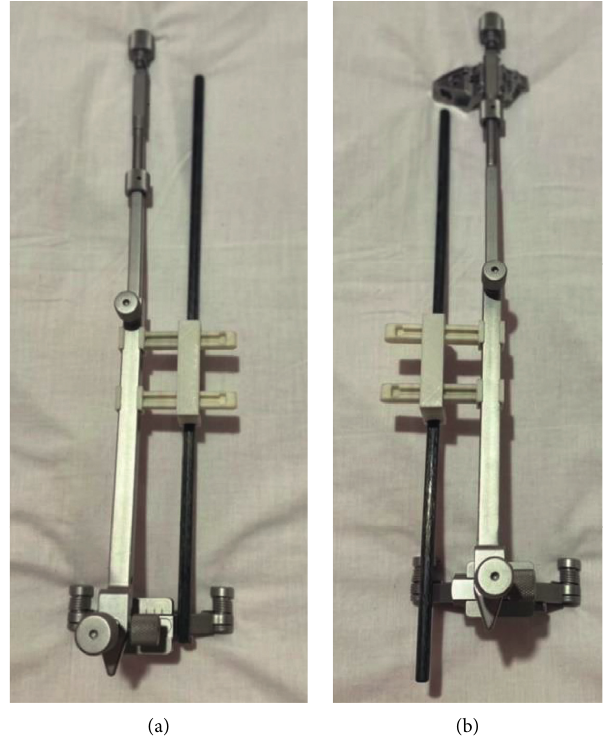
Figure 10: The tool can be fixed for both right and left sides. (a) Right leg. (b) Left leg.